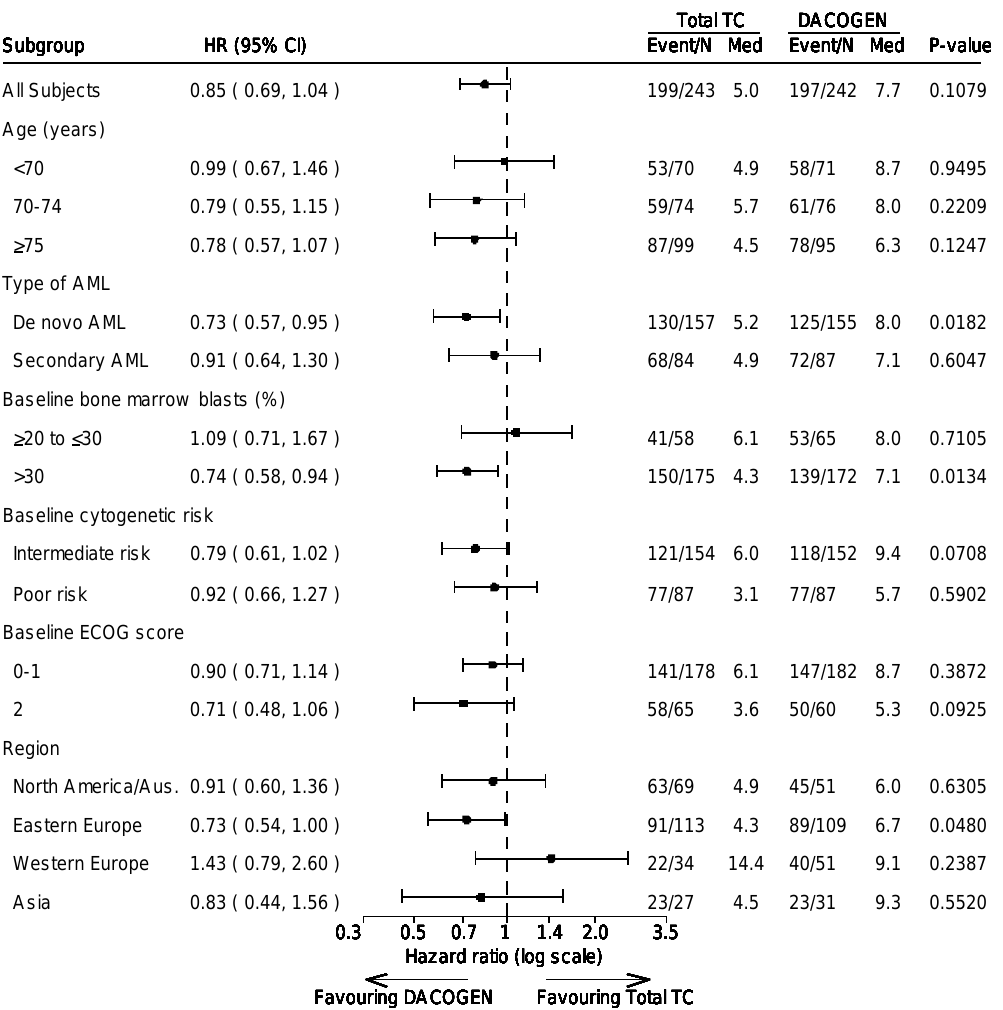
Figure 5: Overall Survival Subgroup Analysis (CCO 2009) (Study DACO-016: Intent-to-Treat Analysis